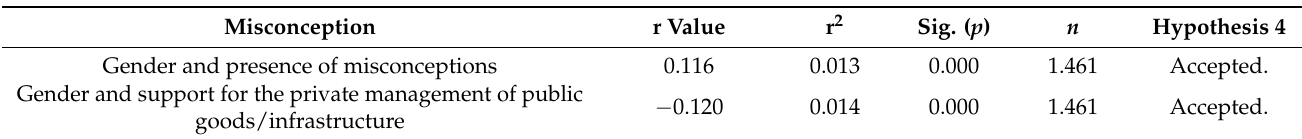
Table 5. Correlation between gender and the presence of misconceptions, and between gender and support for the private management of public